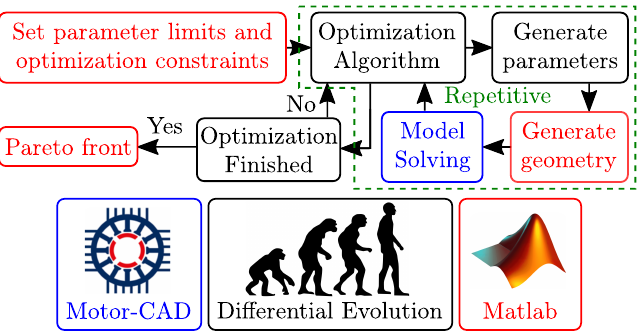
Figure 8. Typical optimization